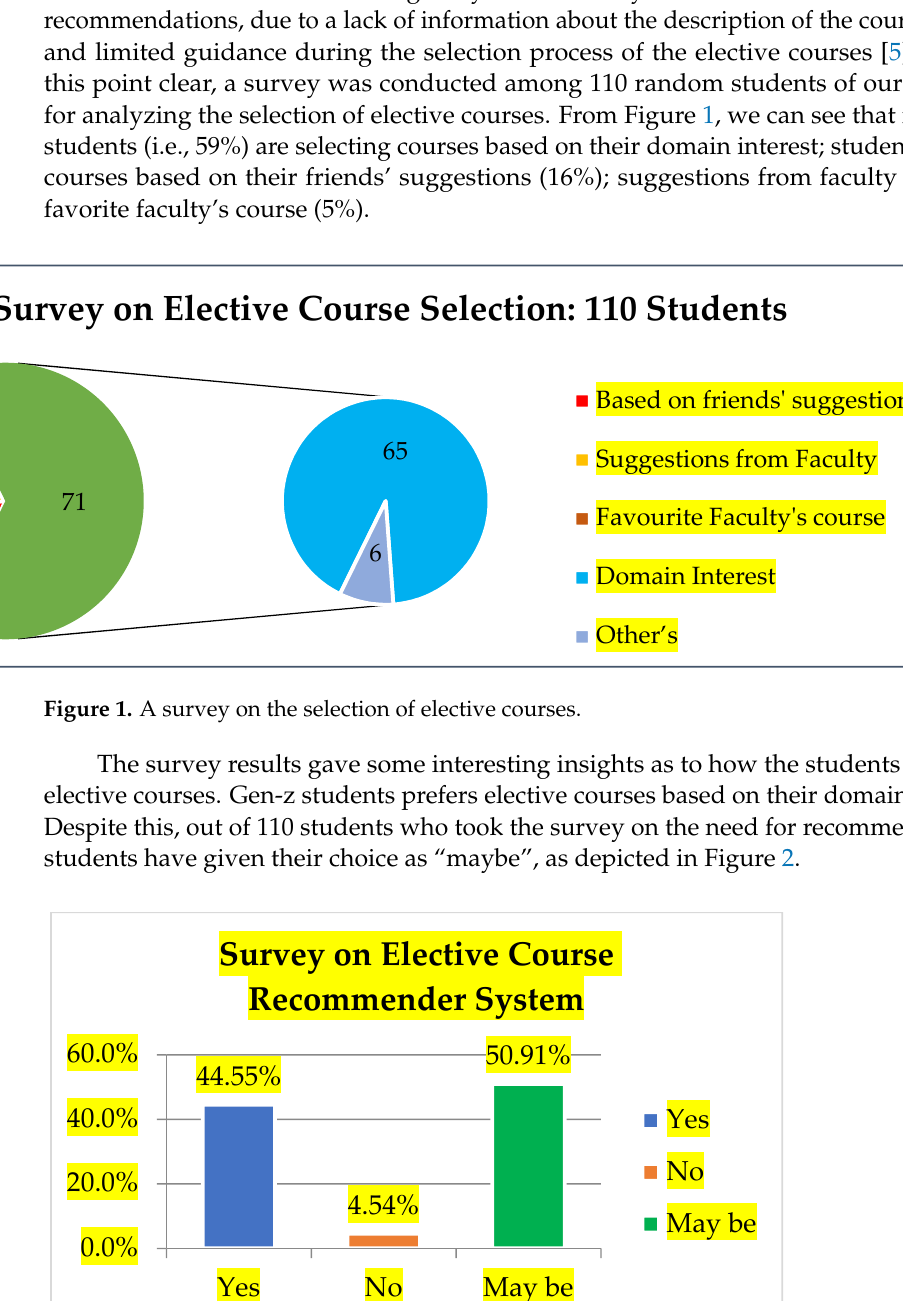
Figure 2. Students’ insight on course recommendation.